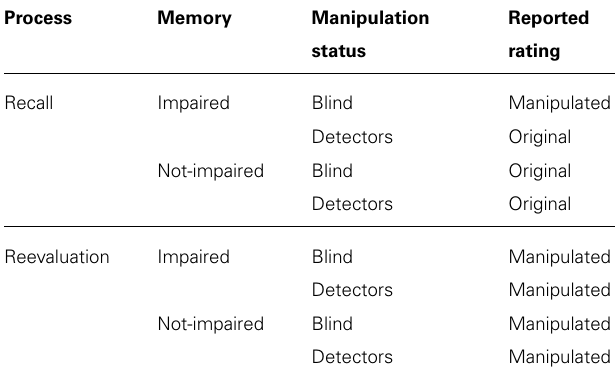
Table 1 | Hypothetical outcomes for reported ratings given the cognitive process, the memory capacity and participants’ manipulation